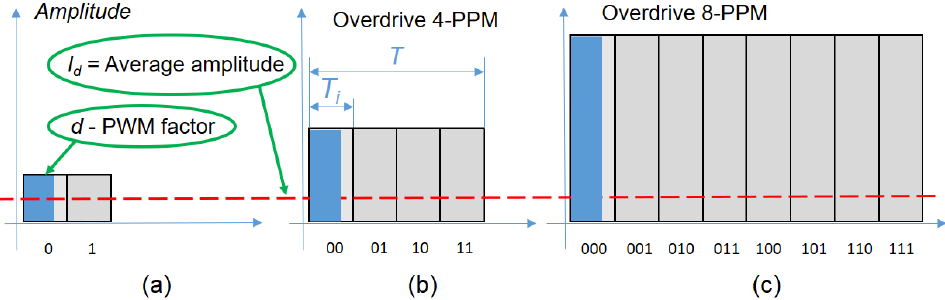
Figure 3. Theoretical analysis for overdriving an LED with a reduced duty factor, using VPPM: ( a ) Manchester code; ( b ) 4-PPM; ( c ) 8-PPM.